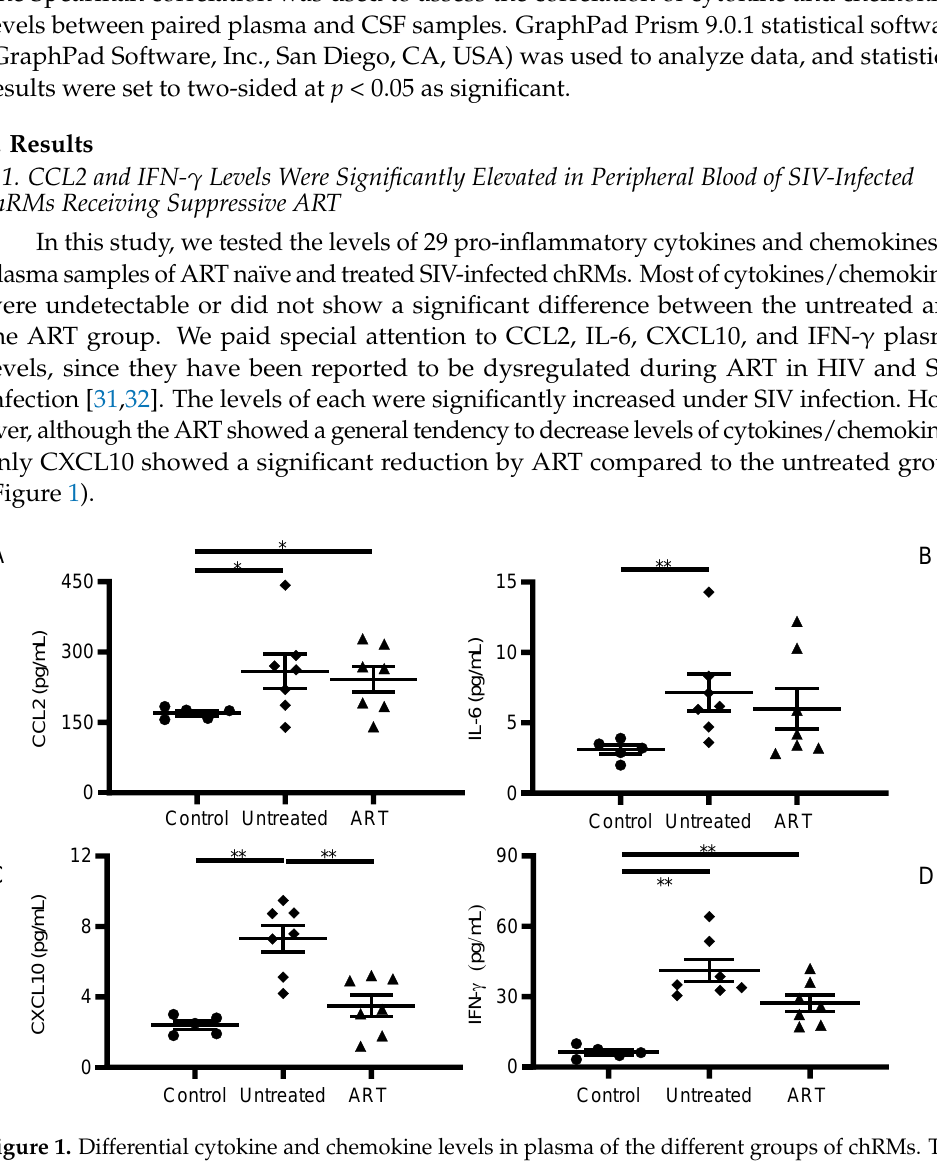
Figure 1. Differential cytokine and chemokine levels in plasma of the different groups of chRMs. The scatter graphs show the distribution observed in the plasma of each group for the cytokines and chemokines: ( A ) CCL2, ( B ) IL-6, ( C ) CXCL10, and ( D ) IFN-g. (* p < 0.05, ** p < 0.01). CCL2 levels were statistically higher in the untreated (259.2 ± 96.62 pg/mL) (mean ± sd) compared to the control group (169.9.3 ± 12.08 pg/mL, p = 0.048). Interestingly, plasma CCL2 levels in the ART group remained elevated and were comparable to the untreated group. The levels were also significantly higher than the control group (242.1 ± 71.13 pg/mL, p =